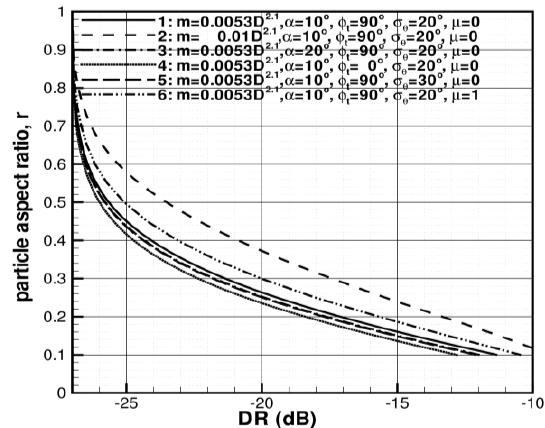
Figure 2. r -DR relations assuming D mv = 0.1 cm and different assumptions for the radar elevation angle α, transmission phase shift φ t , the standard deviation of particle wobbling σ θ , and the coefficients in the particle mass-size relation.